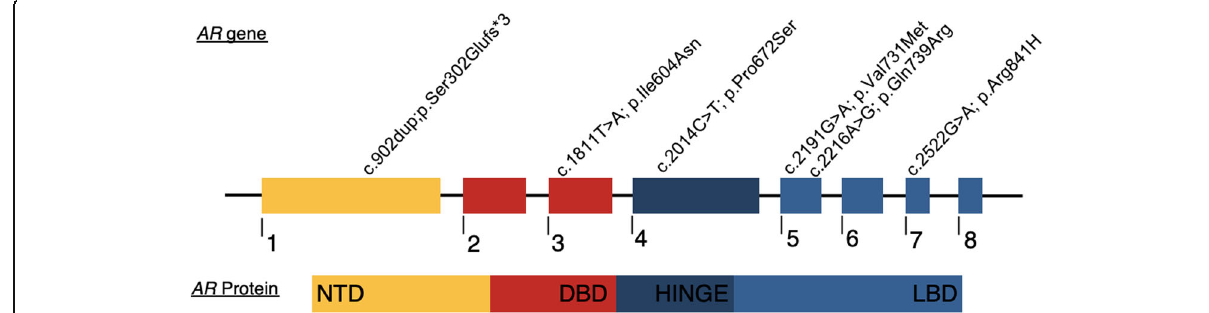
Fig. 1 Schematic diagram showing the AR gene and the localization of the six pathogenic variants identified in the present study. The exons of the AR gene are indicated numbered boxes. AR : androgen receptor